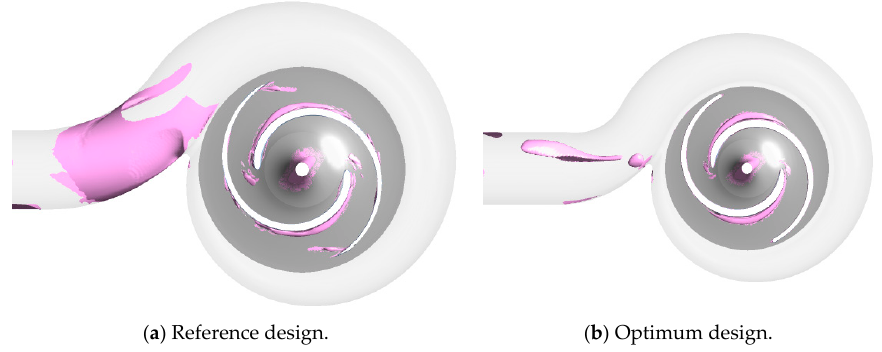
Figure 23. Iso-surface for the low-velocity region (<1 m/s).